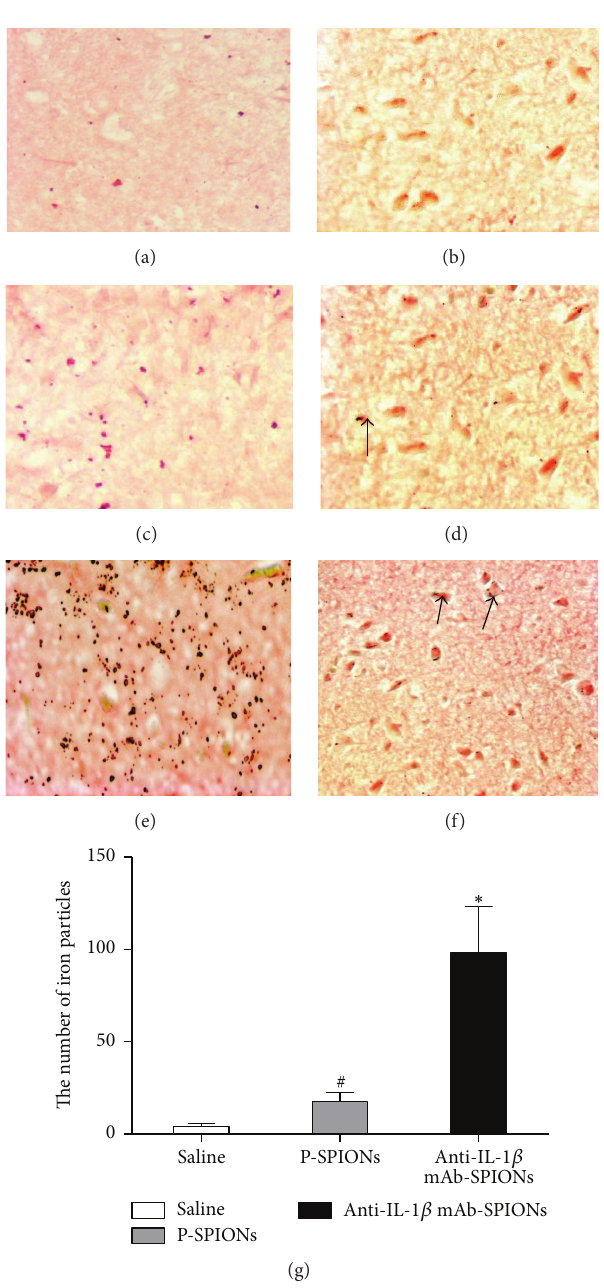
Figure 2: The distribution of iron particles in the hippocampus CA3 of models of TLE at 72 h post-SE after tail vein injection of particles. ((a)-(b)) Perl’s iron staining of saline group; ((c)-(d)) Perl’s iron staining of P-SPIONs group; ((e)-(f)) Perl’s iron staining of anti-IL-1 𝛽 mAb- SPIONs group. ((a), (c), and (e)) Magnification 40; ((b), (d), and (f)) magnification 400; (g) shows bar graphs (mean ± SD, 𝑛 = 10 ) for the number of iron particles. ∗ 𝑃 < 0.01 versus saline group. # 𝑃 > 0.05 versus saline group and anti-IL-1 𝛽 mAb-SPIONs